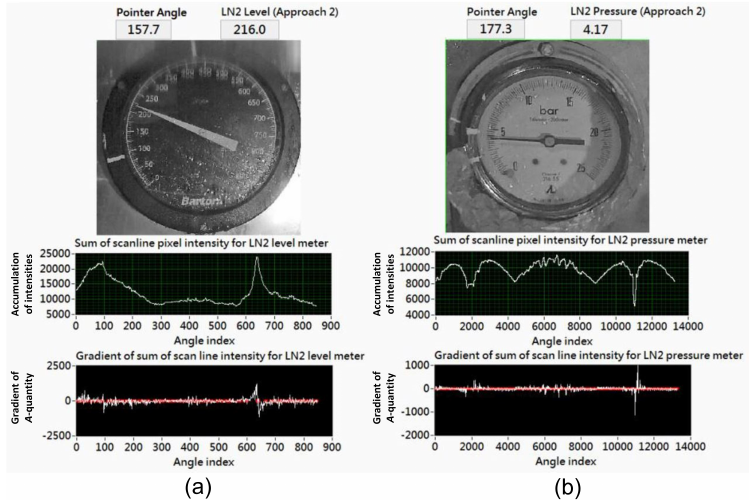
Figure 25. Results of reading ( a ) the level meter and ( b ) the pressure meter the rainy night scenario given in Figure 24.